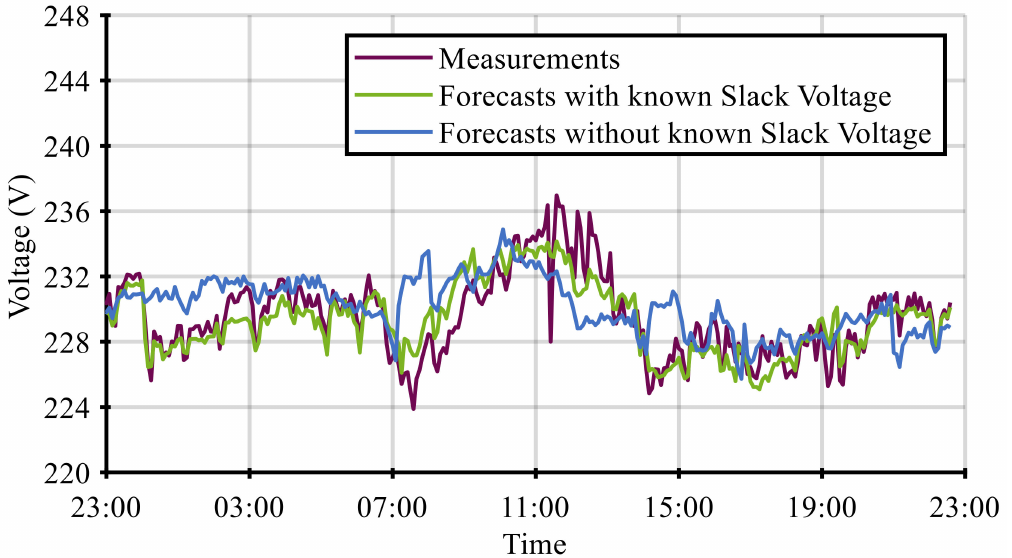
Figure 12. The e ff ect of knowing the slack voltage on a node voltage